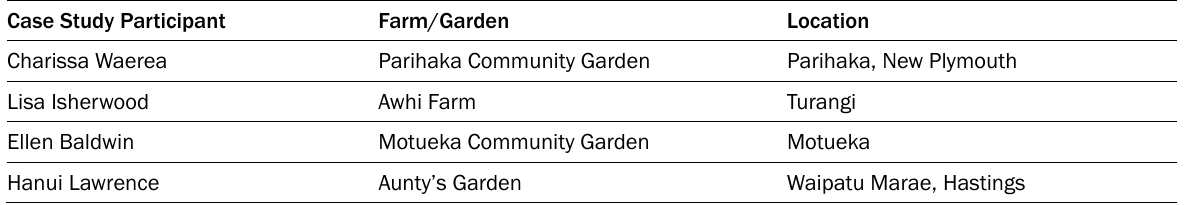
Table 1. Participating Farm/Garden List Case Study Participant